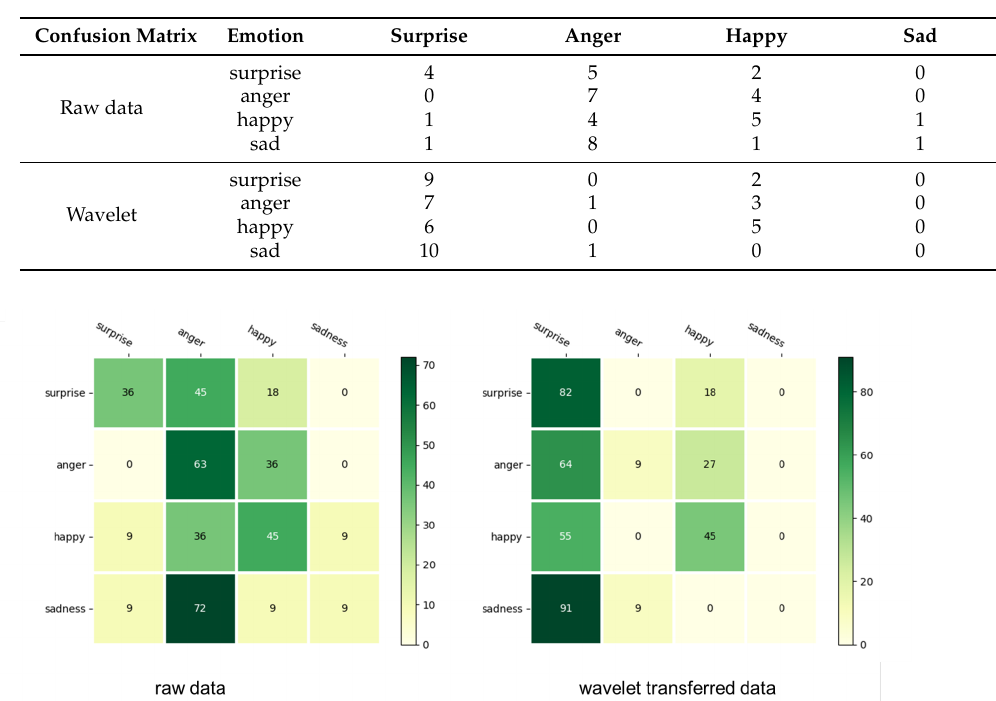
Table 3. Confusion matrix of raw data and wavelet data.